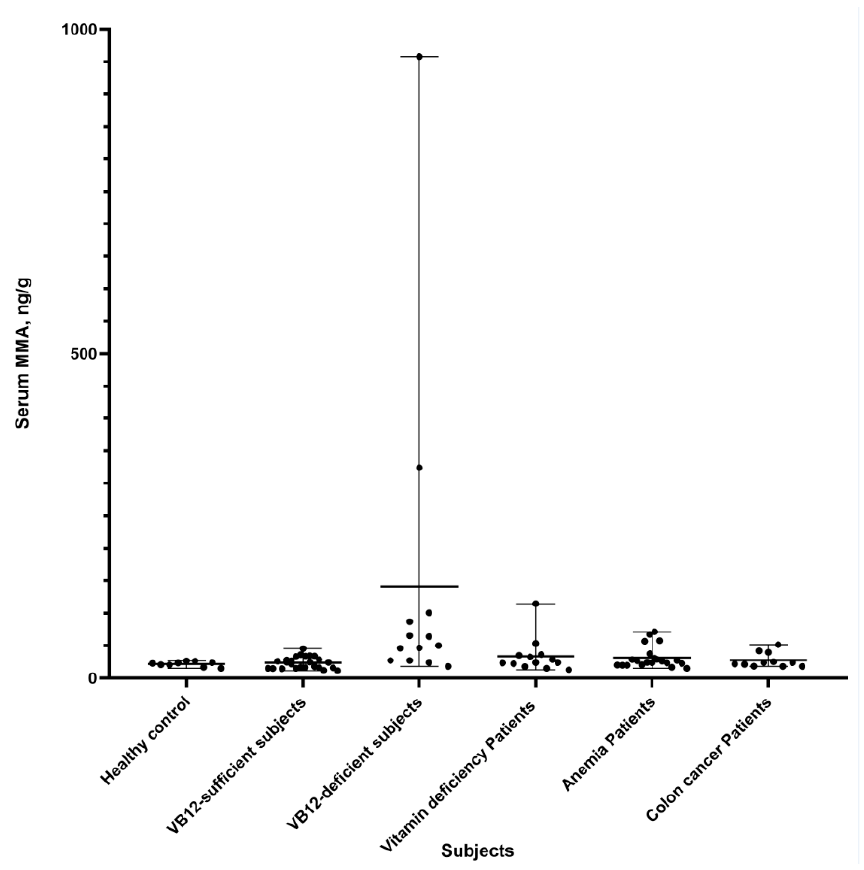
Figure 3. Methylmalonic acid levels in clinical subjects.